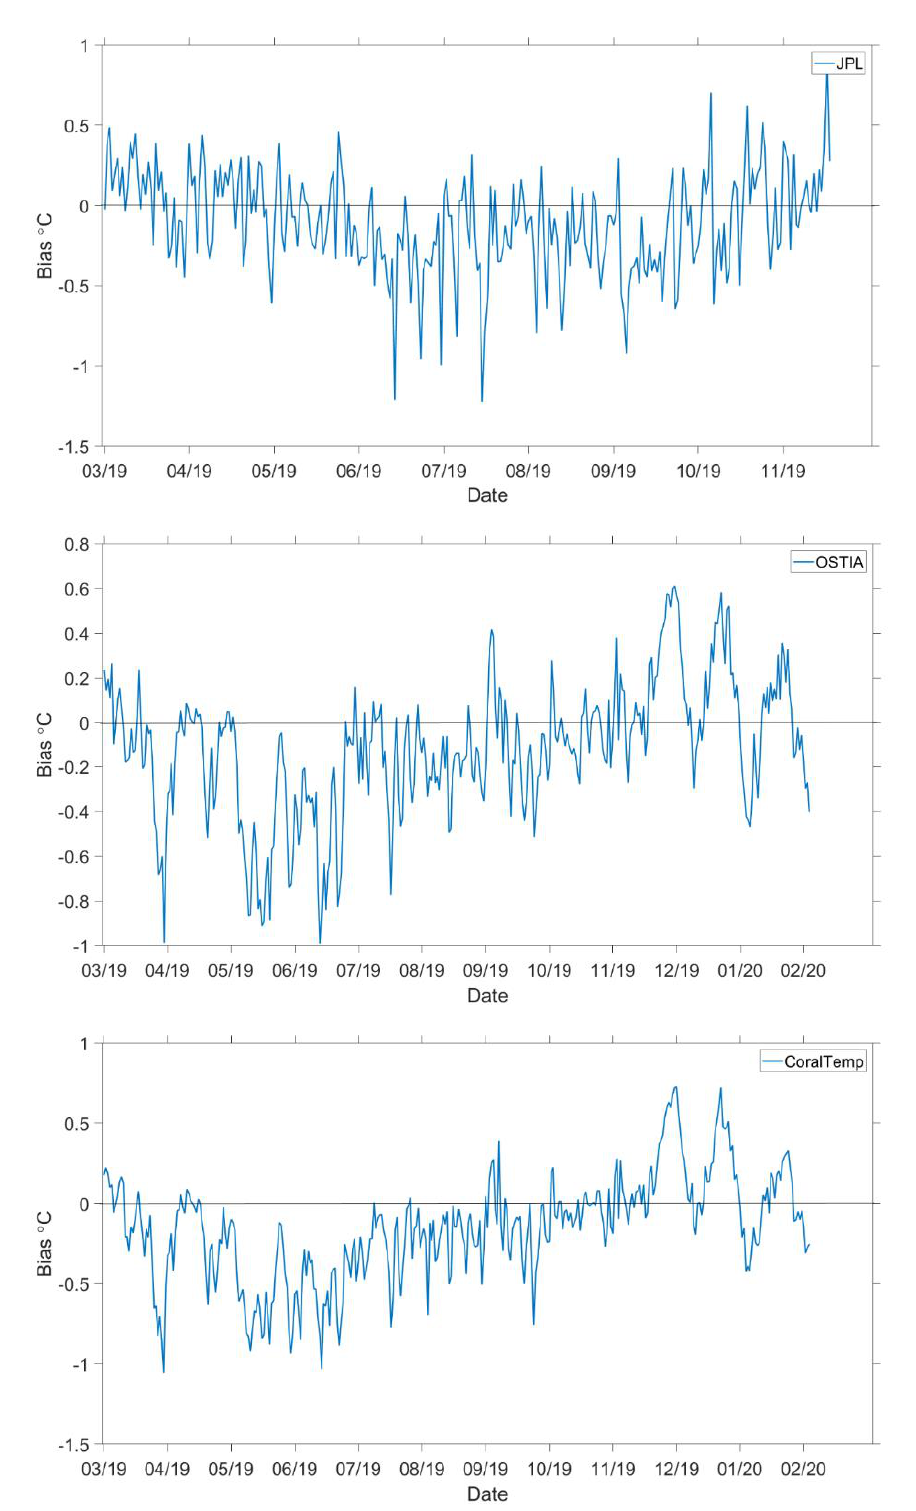
Figure 6. Time series of the bias (satellite—in situ) temperatures from 1 March 2019–1 March 2020 for San Cristobal.